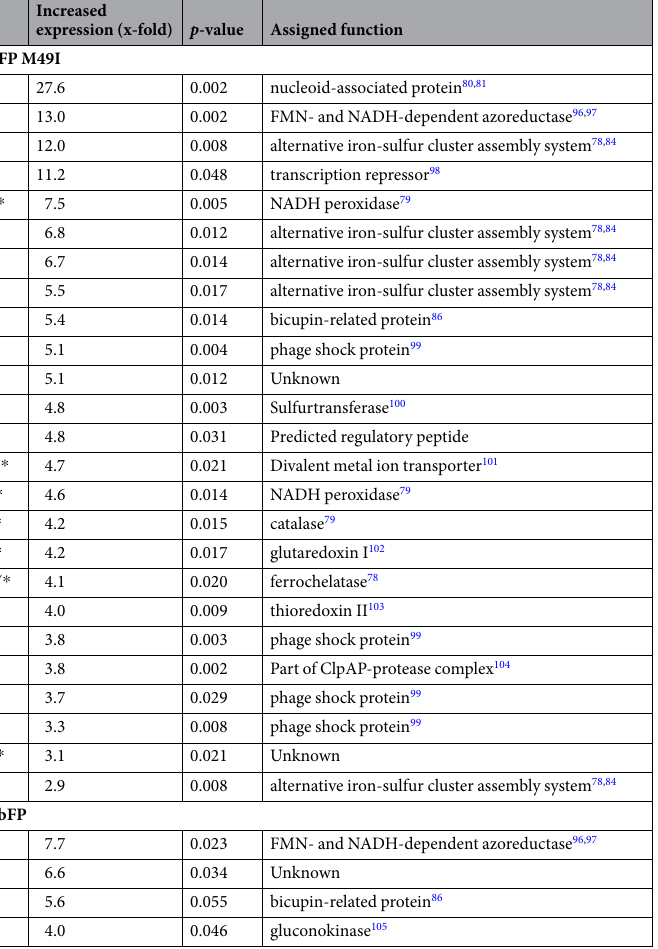
Table 2. DNA microarray-based, genome-wide analysis of ROS-induced stress response mediated by light- exposed LOV-PS in E . coli . LOV-PS Pp2FbFP and DsFbFP M49I were expressed in E . coli BL21(DE3) cells and illuminated with blue light (Pp2FbFP: 5 min, DsFbFP: 15 min). Transcriptome profiles were compiled from illuminated samples and compared to non-illuminated controls. In this way, genes were identified that showed a significant increase in their expression level ( ≥ 3-fold, p -value ≤ 0.05), as a reaction to light exposure. Genes